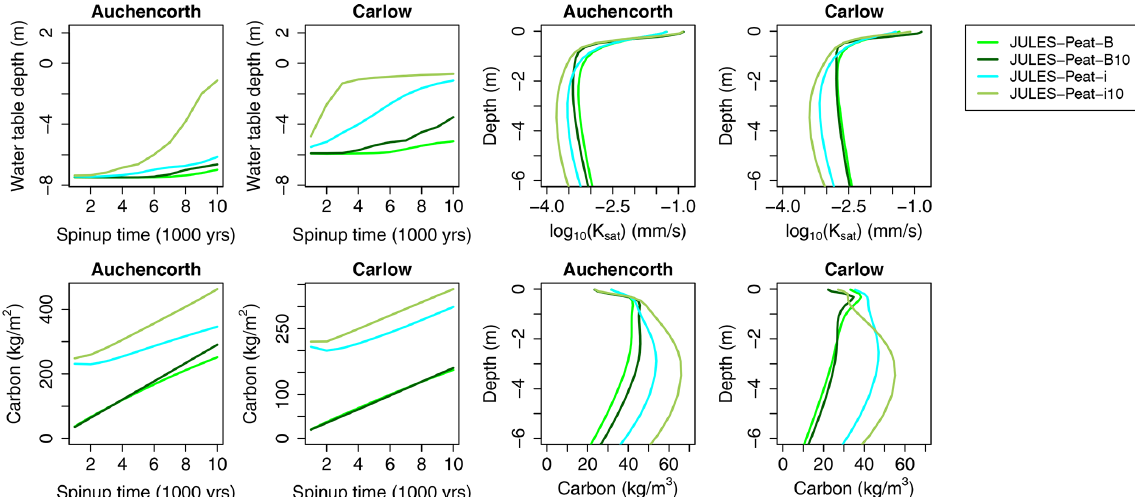
Figure 10. Hydrological feedback between peat accumulation and water table level. Note that the spin-up time is noted in thousands of years so the total spin-up period is 10000 years. Vertical profiles of K sat and carbon are shown at the end of the spin-up.